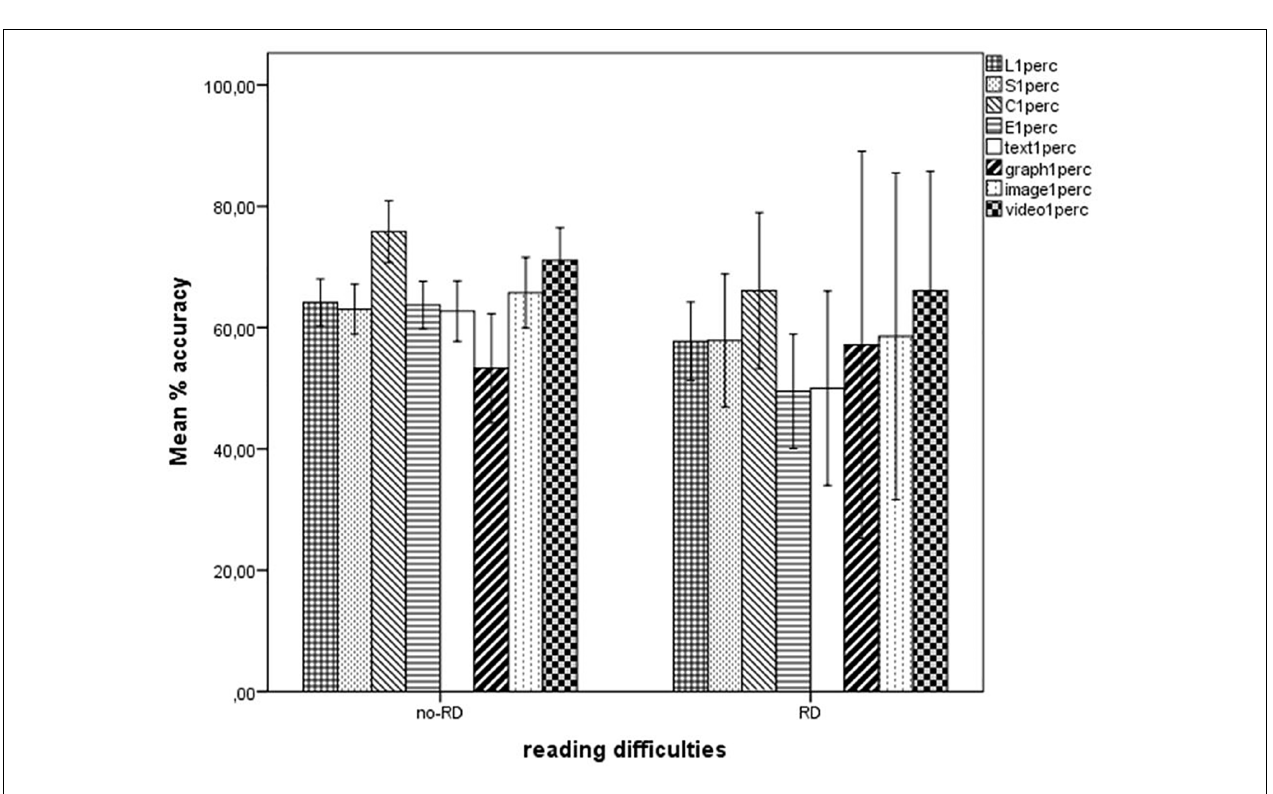
Frontiers in Psychology |